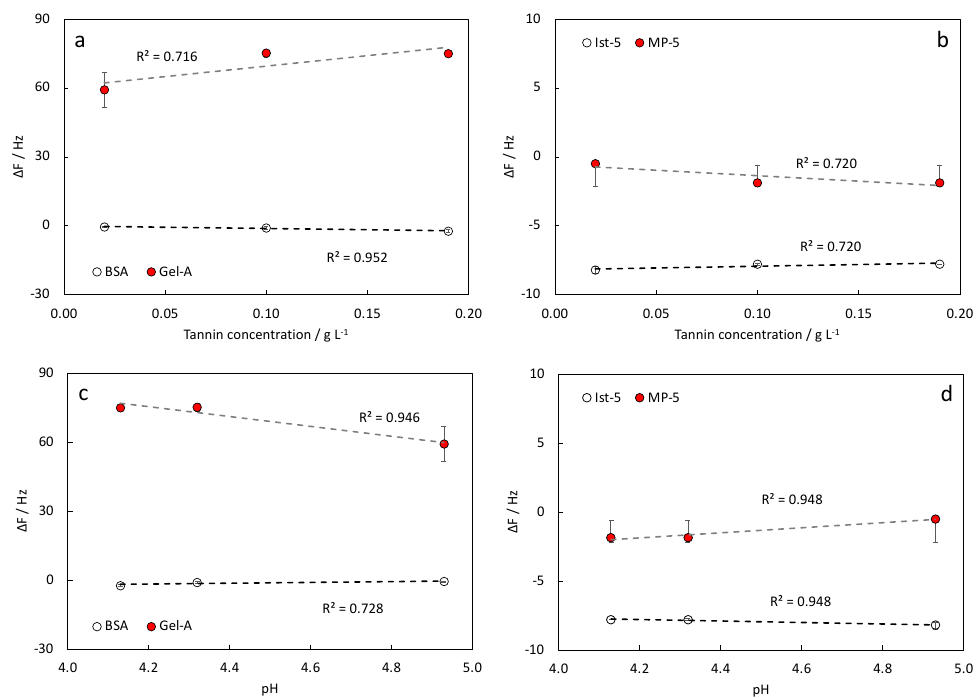
Figure 5. Detection of polyphenols in watery solutions containing TG: ∆ f vs. tannin concentration in ( a ) proteins, ( b ) peptides; ∆ f vs. pH in ( c ) proteins, ( d )